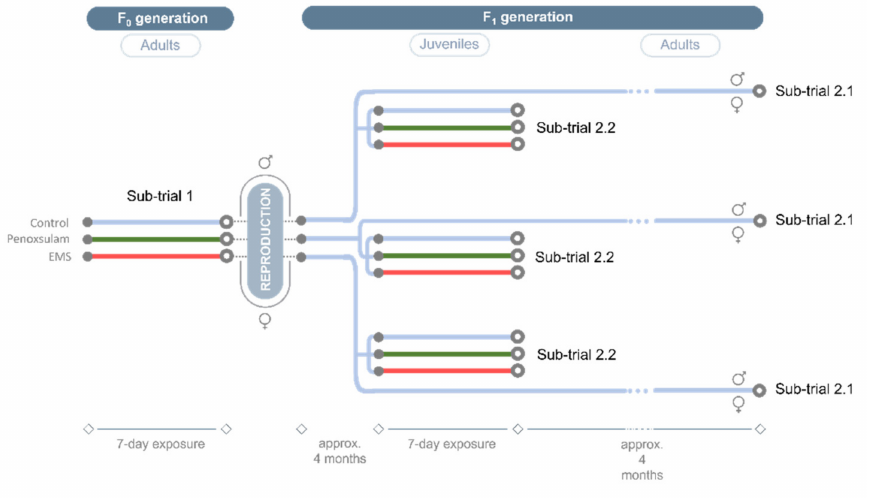
Figure 1. Schematic representation of the experimental design, depicting an intergenerational trial involving the exposure of the red swamp crayfish ( Procambarus clarkii ) to the genotoxicants penoxsulam (Px; green line) and ethyl methanesulfonate (EMS; red line). Sub-trial 1: exposure (7 days) of male ( ) and female ( ) adults, from F 0 , to Px and EMS, in comparison with a control group (blue line). After reproduction of the F 0 organisms (intragroup crosses), F 1 offspring were divided into two sub-trials (2.1 and 2.2). Sub-trial 2.1: the progeny (F 1 ) of each F 0 group was allowed to grow in uncontaminated water until adulthood (blue line); global DNA methylation was analyzed in both stages (juvenile and adult). Sub-trial 2.2: the progeny (F 1 ) of each F 0 group was allowed to grow in uncontaminated water only until the juvenile stage and then exposed to Px and EMS for 7 days, and thereafter analyzed in comparison with a control group. represents the sampling moments.